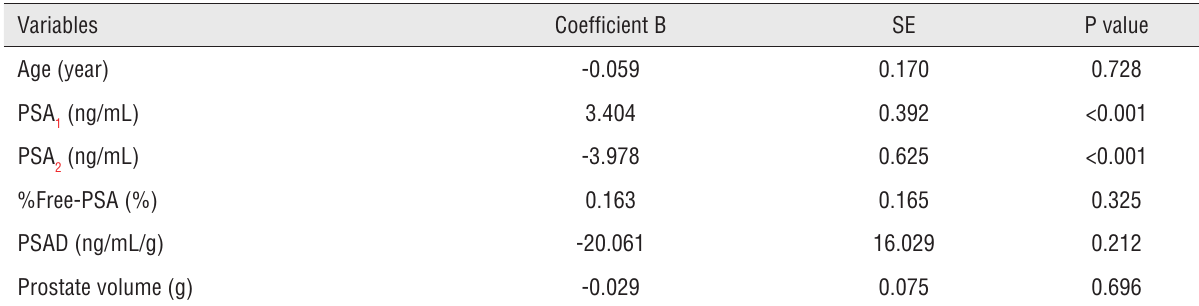
Table 3 - Simple linear regression analyses of prostate-specific antigen fluctuation and clinical parameters. Variables Coefficient B SE